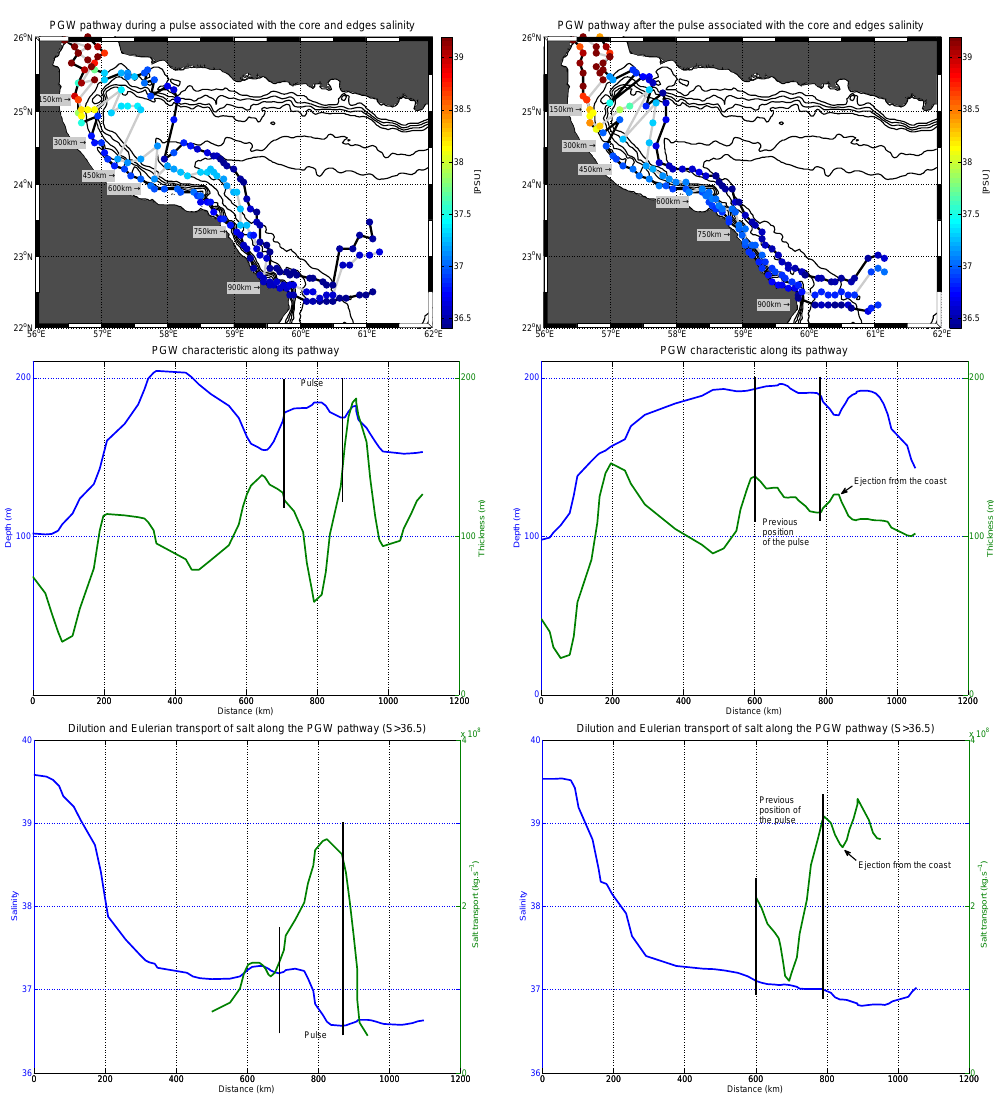
Figure 18. Evolution of the PGW characteristics during the pulse (on 3 August, left) and after the pulse (on 21 August, right). The first row shows the pathway of the maximal salinity of PGW and the width of the outflow. The second row displays the depth and thickness of the outflow and the third row maximal salinity and transport of salt along the downstream